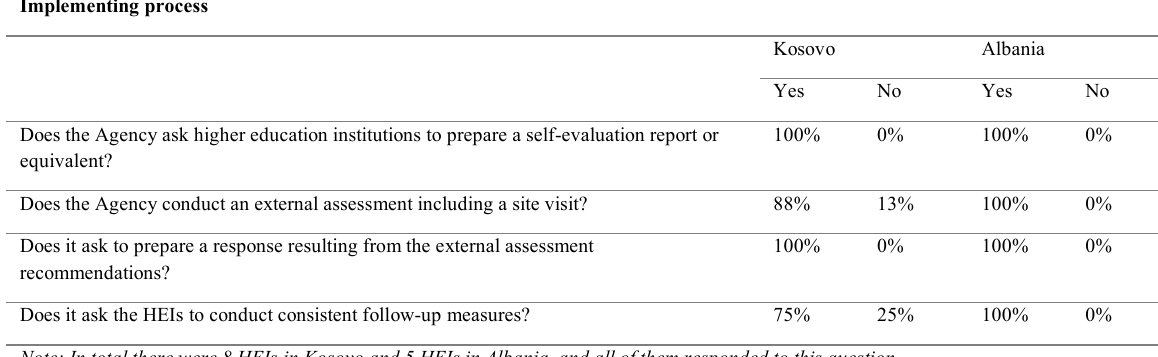
Table 8 : External Quality Assurance: Implementing process in the HEIs in Kosovo and Albania Implementing process